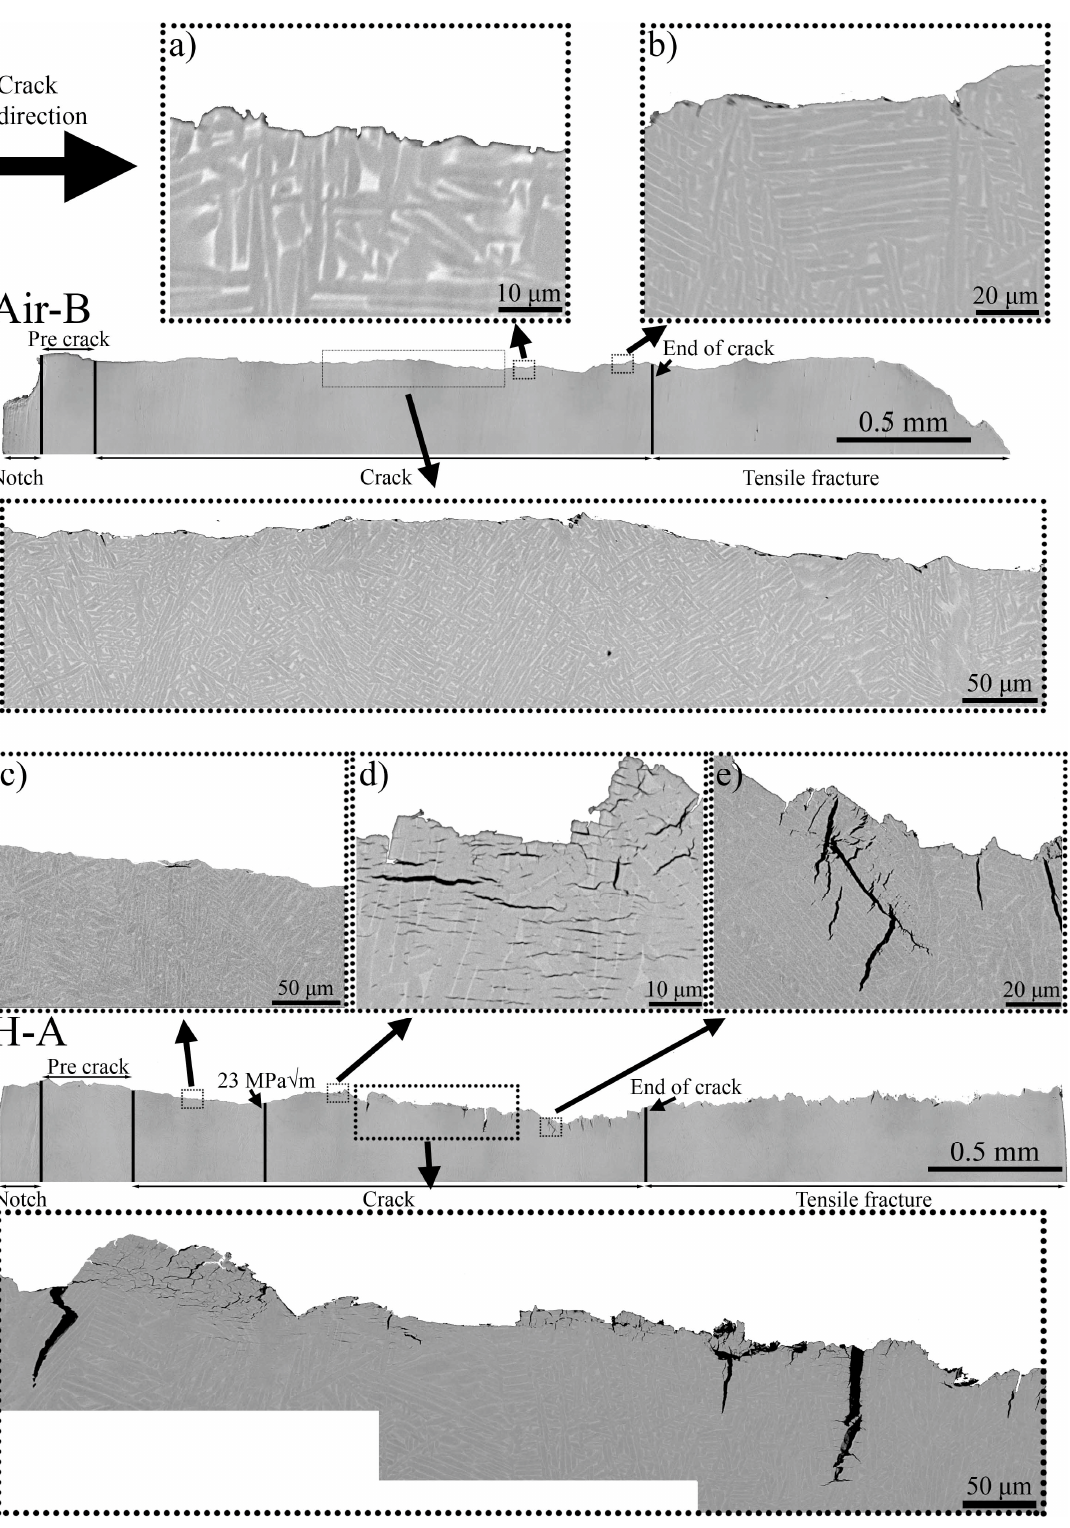
Figure 12. Crack-profiles of Air-B and H-A samples. The crack profiles correspond to a cross-section illustrated in Figure 6 as a white vertical line. In H-A, many larger cracks that grew perpendicular to the fracture surface were observed, along with numerous smaller secondary cracks that grew parallel. In H-A the crack path was tortuous, whereas in Air-B it was comparably smooth. Compared to H-A no cracks were present in Air-B. Images ( a – e ) show magnified areas.